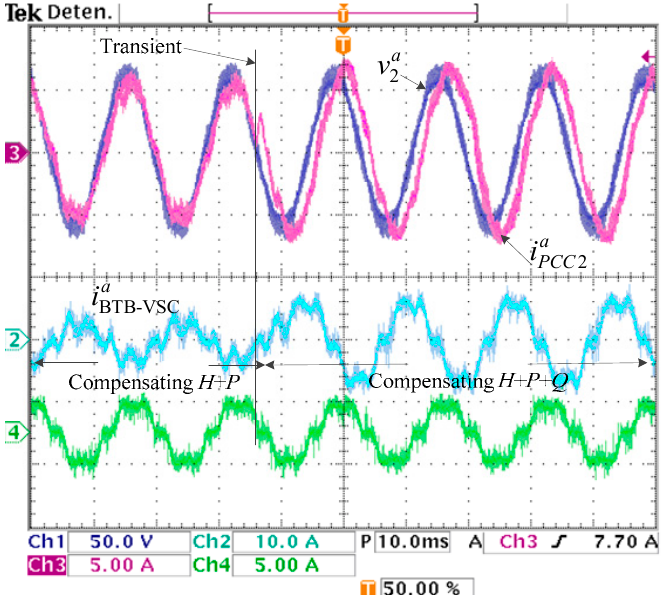
Figure 18. Test results for compensation of current harmonics, active and reactive powers. Ch1, voltage measured at the PCC2; Ch2, current injected with the BTB-VSC; Ch3, current measured at the PCC; Ch4, nonlinear current. Vertical sensitivities: Ch1, 50V / div; Ch2, 10A / div; Ch3 and Ch4, 5 A / div. Horizontal sensitivity: 10 ms/div.